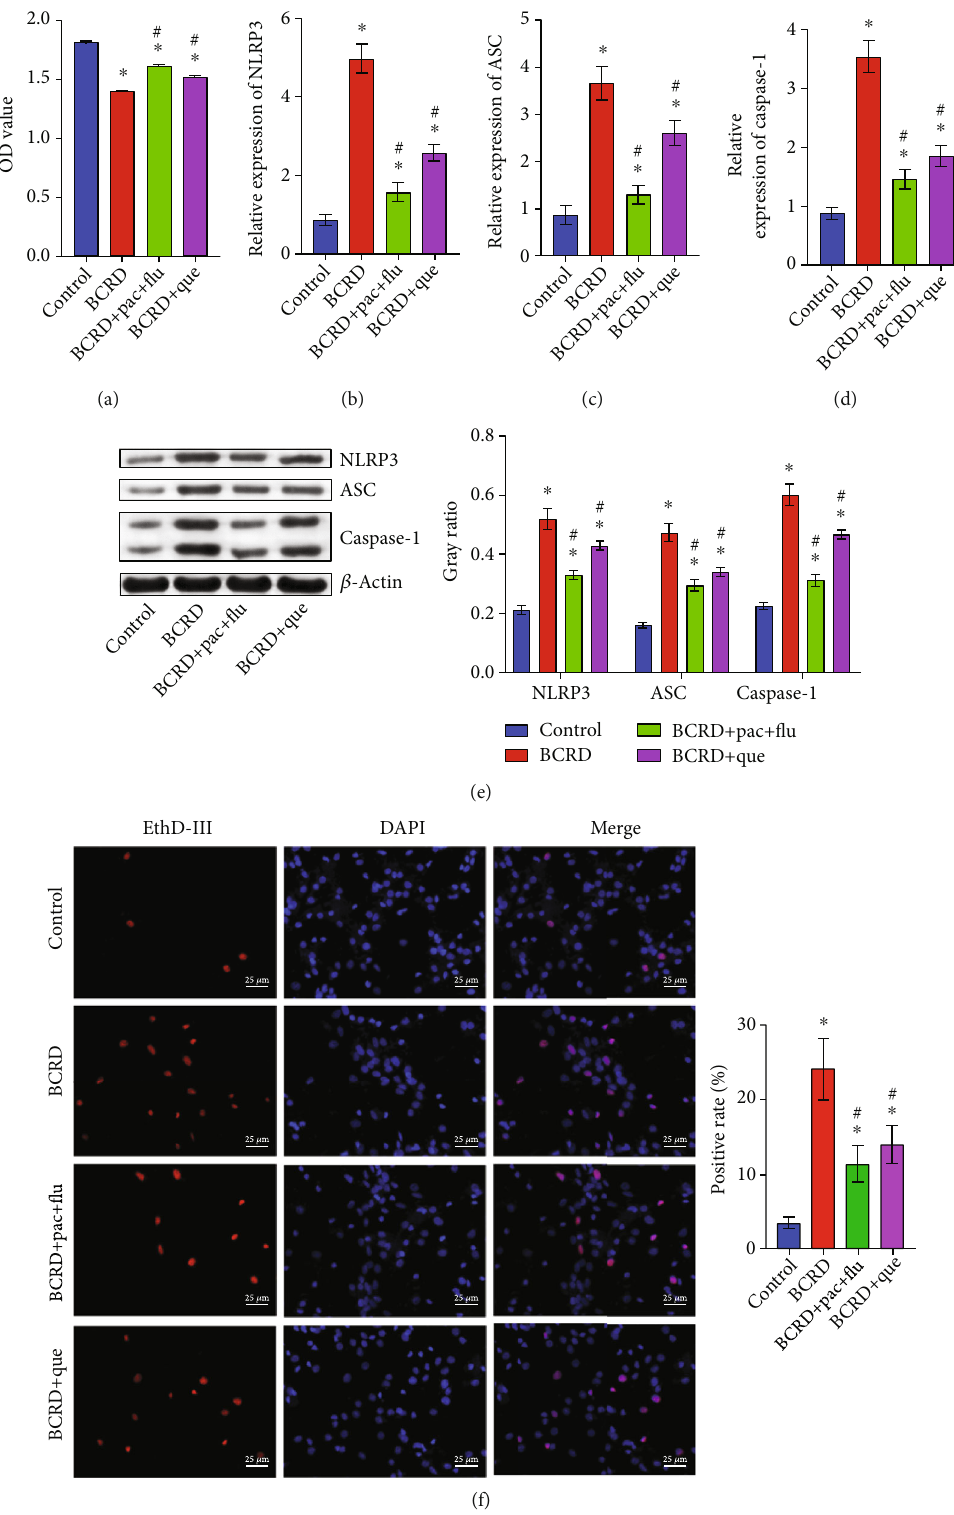
Figure 4: Quercetin signi fi cantly reversed BCRD-induced cell pyroptosis. Neurons were divided into BCRD, BCRD+quercetin, or BCRD +Pac+Flu. (a) The viability of neurons was assessed by the CCK8 assay. (b – d) The levels of NLRP3, ASC, and caspase-1 in neurons were investigated by RT-qPCR. (e) ASC, NLRP3, and caspase-1 levels in neurons were investigated by western blot. β -Actin was applied for quanti fi cation. (f) The pyroptosis of hippocampal neurons was evaluated by EthD-III staining ∗ p < 0 : 05 compared with control. # p < 0 : 05 compared with